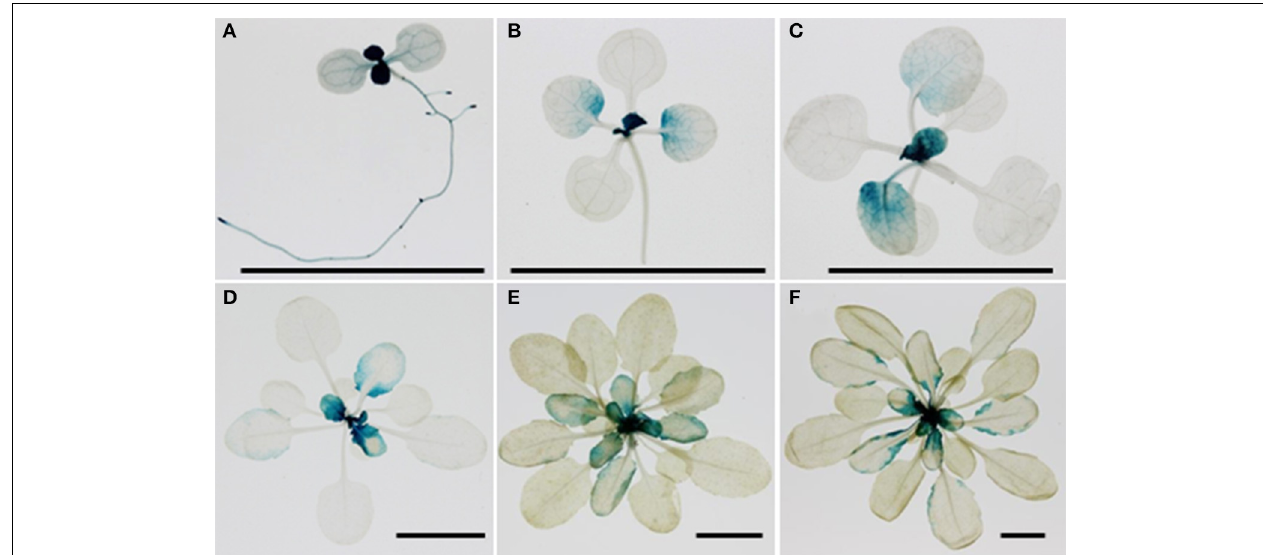
FIGURE 7 | Developmental patterning of MNM1 . Shown is histochemical GUS staining of transgenic Arabidopsis plants expressing the MNM1 translational fusion from the Sha accession in the Col-0 background. Three independent transgenic lines per construct were visualized for each time point and a representative image is shown. The black bar in each graph represents a 1cm scale. (A) One-week-old seedling grown in MS medium